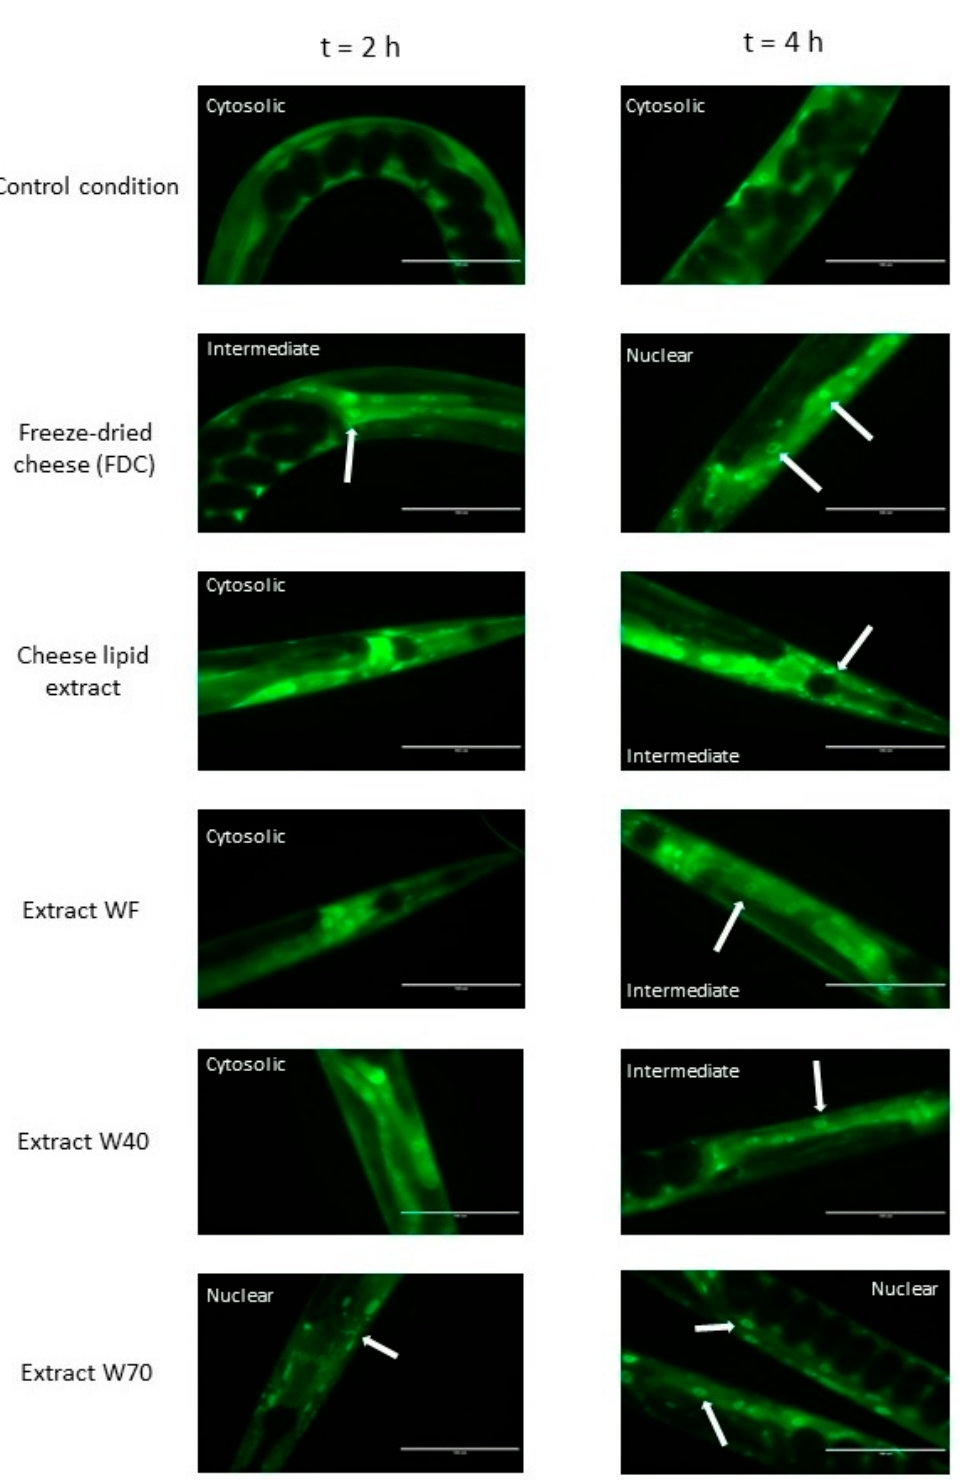
Figure 5. The effects of the FDC (freeze-dried cheese) and the extracts on DAF-16 cellular localization in C. elegans transgenic strain TJ356 expressing DAF-16::GFP, after 2 h and 4 h of incubation on the supplemented medium. The arrows indicate the accumulation of the transcription factor in the nuclei. Scale bar: 100 µm.